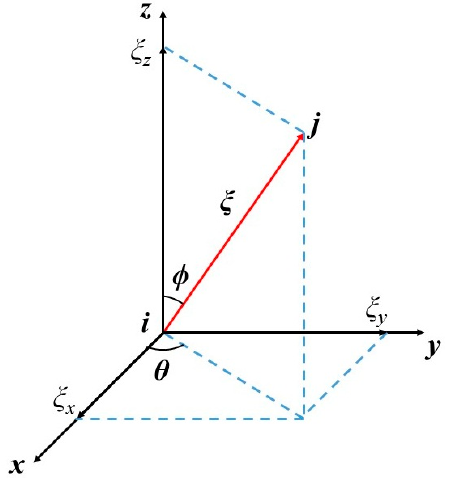
Figure 2. Diagram of three-dimensional bond orientation.